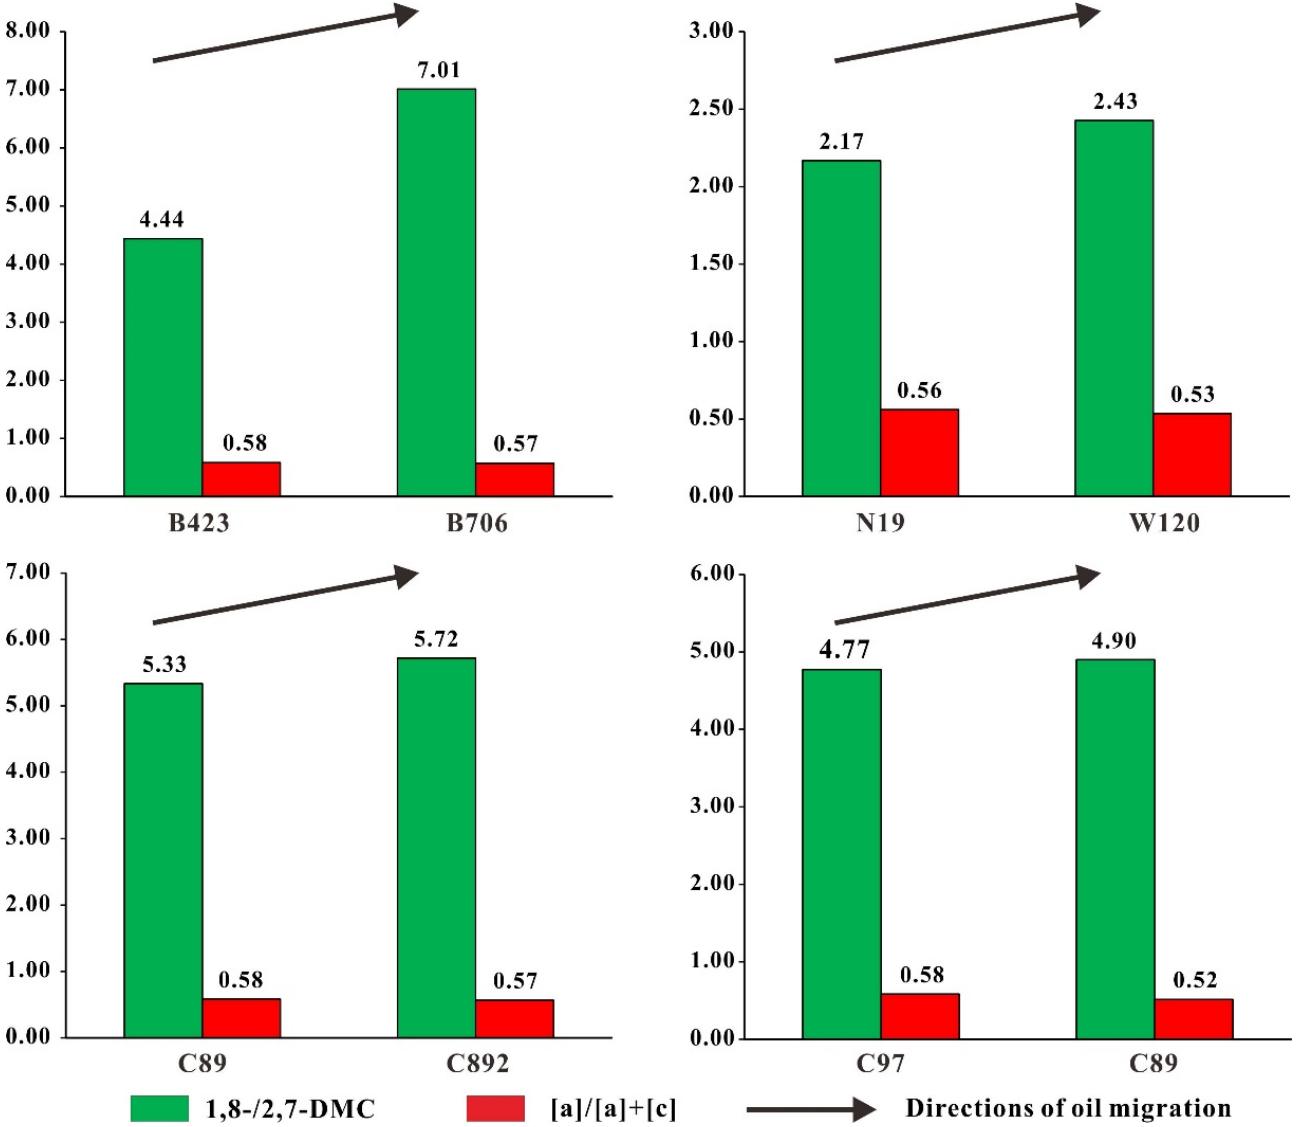
Figure 10. Histogram of carbazole compound ratios (migration parameters) of crude oil samples of Dongying Depression.